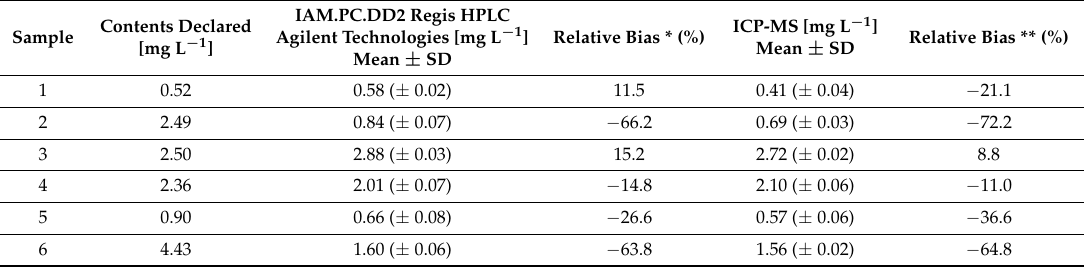
Table 5. Iodide content in selected mineral waters (n = 3 each) analyzed by HPLC-DAD on IAM.PC.DD2 Regis HPLC Agilent Technologies and